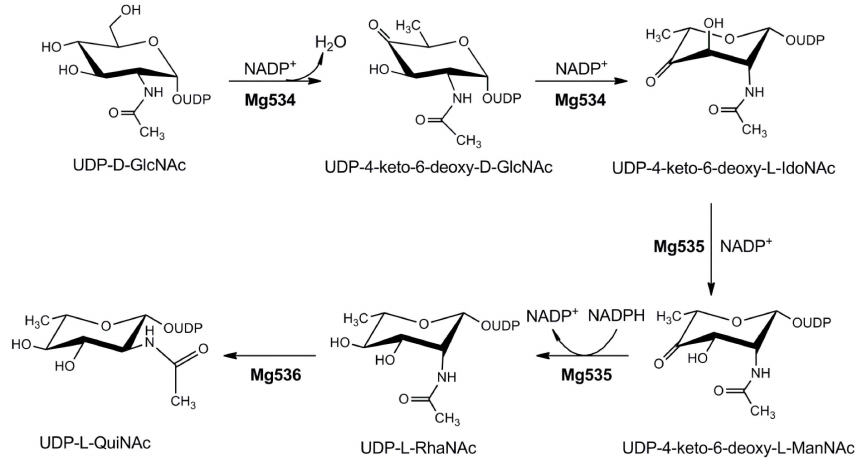
Figure 4. Metabolism of 2-acetamido-2,6-dideoxyhexoses in Megavirus chilensis . Mg534 catalyzes the 4,6-dehydration, 5-epimerization of UDP- N -acetyl- D -glucosamine with the formation of UDP-4- keto-6-deoxy- N -acetyl- L -idosamine. This compound is then epimerized on C-3 and reduced on C-4 by Mg535, to give UDP- N -acetyl- L -rhamnosamine. The 2-epimerase activity of Mg536, producing UDP- N -acetyl- L -quinovosamine has not been experimentally